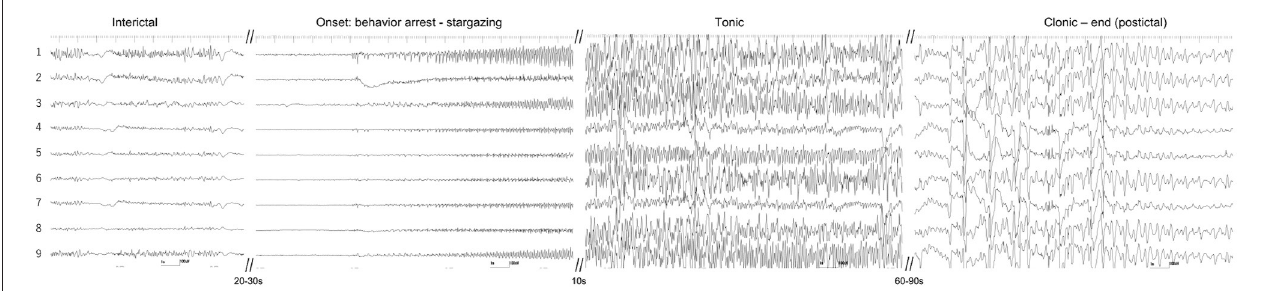
FIGURE 6 | Ictal ECoG of a spontaneous focal limbic seizure evolving into a generalized tonic-clonic seizure. Interictal spikes were mainly observed at electrodes #1 and 9. Seizure activity began as a low-voltage fast wave in all electrodes and the rhythmic discharge started from electrodes #1, 3, and 9. It evolved into a generalized tonic-clonic seizure. See also the movie of intracranial video-EEG ( Supplementary Video 1 ).